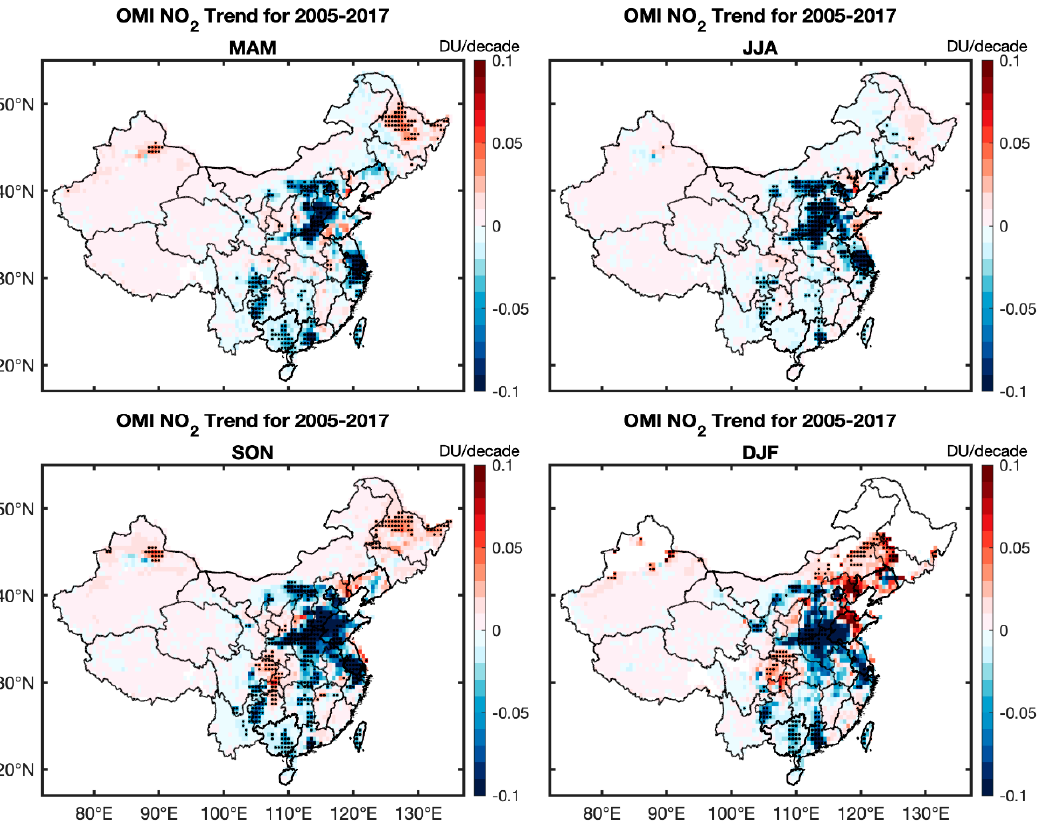
Figure 10. Seasonal OMI NO 2 trends for 2005–2017.